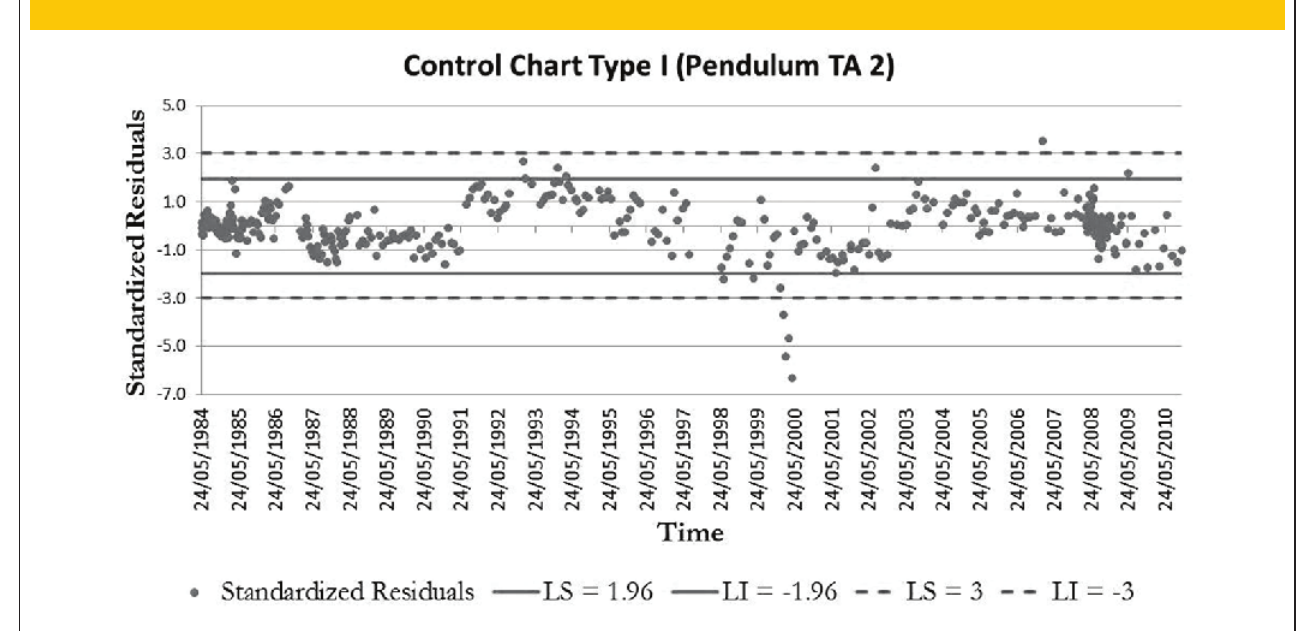
Figure 5 – Control chart for the residuals of the direct pendulum, Control Type